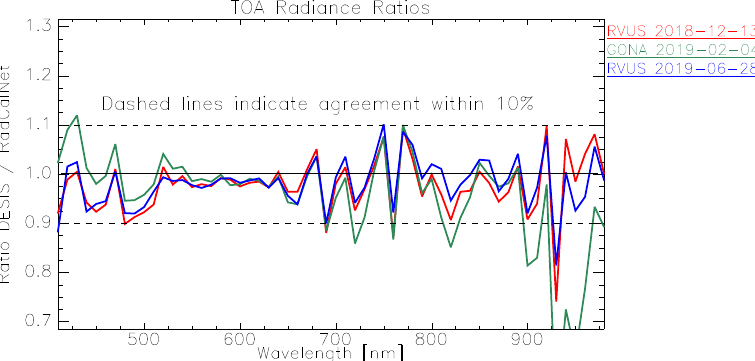
Figure 14. Ratio of mean DESIS TOA-L and corresponding RadCalNet data for all 3 sites, at RadCalNet spectral